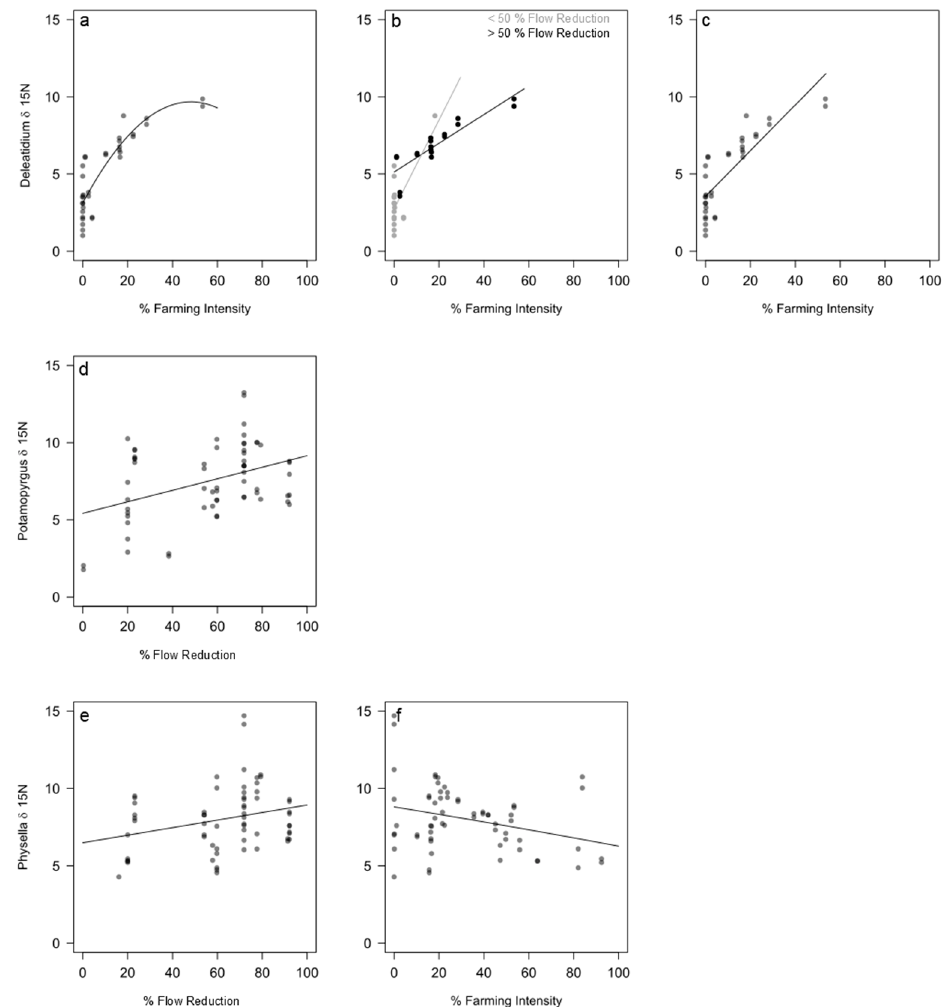
Figure 4. Relationships between primary consumer δ 15 N values and sheep/beef farming intensity and flow reduction derived from the model selection procedure. The plots show the relationships for each of the competing best models including farming intensity or flow reduction as predictor variables (3 models for Deleatidium ( a – c ), 1 for Potamopyrgus ( d ) and 2 for Physella ( e , f ); see Table 1 for details). The plots encompass the range of stressor values across the study sites and riffle/pool habitats (note the plotted range of farming intensities is smaller for Deleatidium ). The interaction plot for Deleatidium ( b ) shows that the relationship with % Farming Intensity is more positive at lower % Flow Reduction (for ease of interpretation, % Flow Reduction was labelled as a factor with 2 levels; grey < 50% Flow Reduction, black > 50% Flow Reduction).